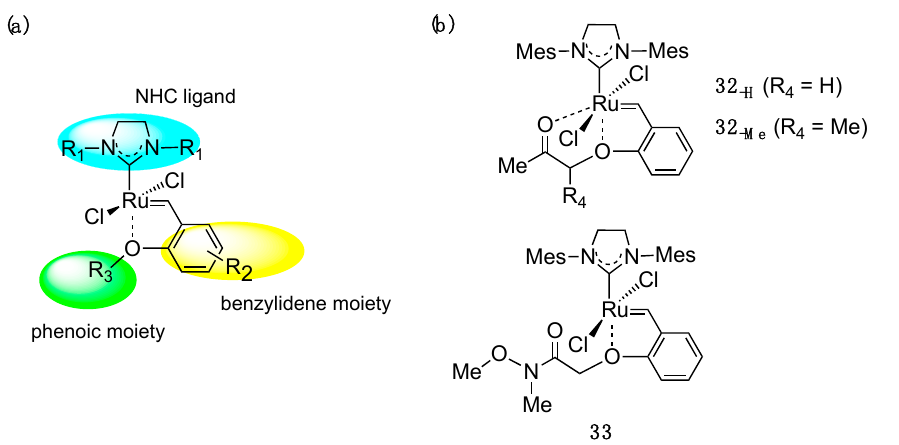
Figure 11. Structural modification of HG-II-type complexes; ( a ) Possible parts for structural modification of HG-II-type complexes [9]; ( b ) Examples of phenolic moiety-modified HG-II-type complexes [7,9,64].